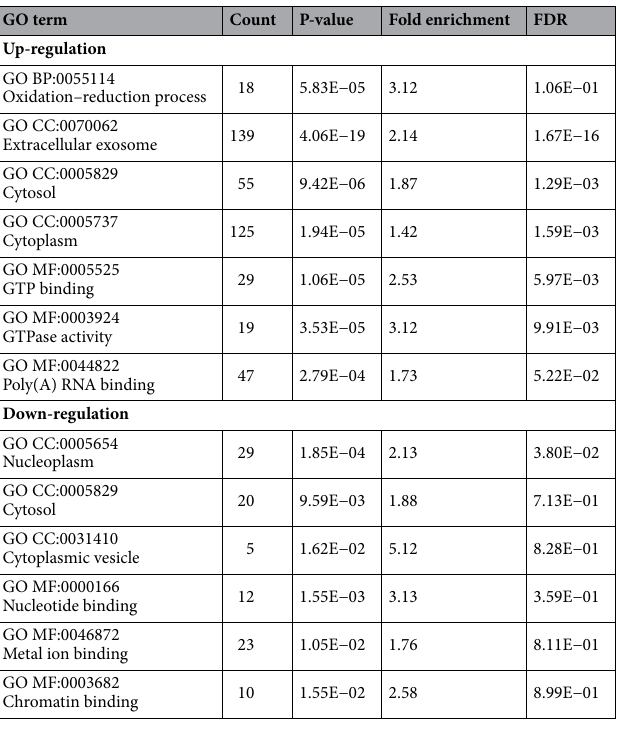
Table 3. Selected based on the high gene count gene ontology (GO) terms evaluated in the myometrium of pigs during the peri-implantation period in response to peri-conceptional undernutrition. BP biological processes, CC cellular components, MF molecular functions.